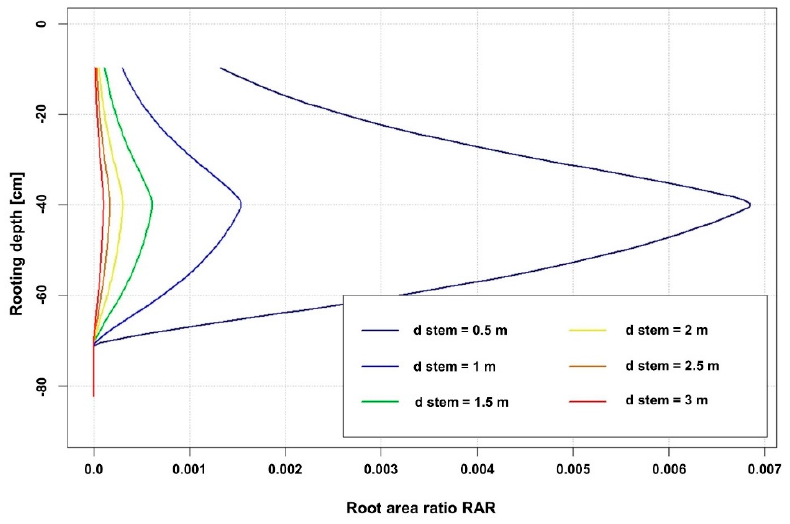
Figure 2. Modeled mean root area ratio (RAR) distribution of white alder (Alnus incana L.) in a modeled vertical profile at six lateral (radial) positions from the tree stem (d stem = 0.5 m, 1.0 m, 1.5 m, 2.0 m, 2.5 m and 3.0 m) with a DBH of 36 cm. Maximum modeled rooting depth was 74 cm. Note that the integral of the RAR distribution in vertical direction equals the mean RAR per total surface of the plot at six lateral (radial) positions.